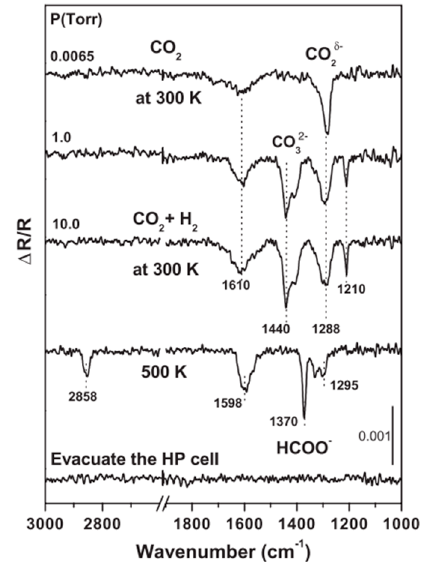
Figure 10. IRRAS spectra at ambient pressures. The spectra were obtained after the exposure of CeO x /Cu(111) to CO 2 and H 2 at the indicated pressures and temperatures. All the spectra except the one at the bottom were collected in the presence of CO 2 or a CO 2 +H 2 mixture at the indicated pressures. ∆ R / R, normalized reflectivity change. Reprinted with permission from Reference [58]. Copyright 2014, The American Association for the Advancement of Science.